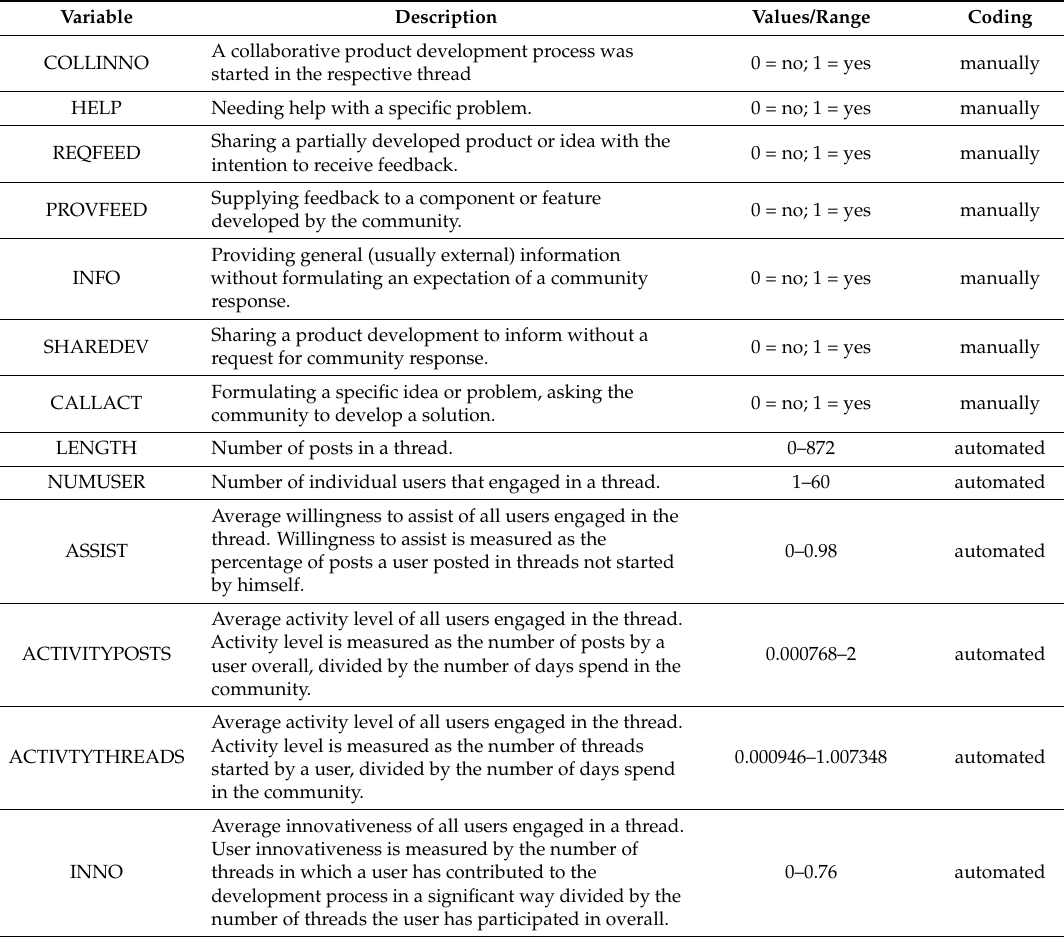
Table 1. Description of